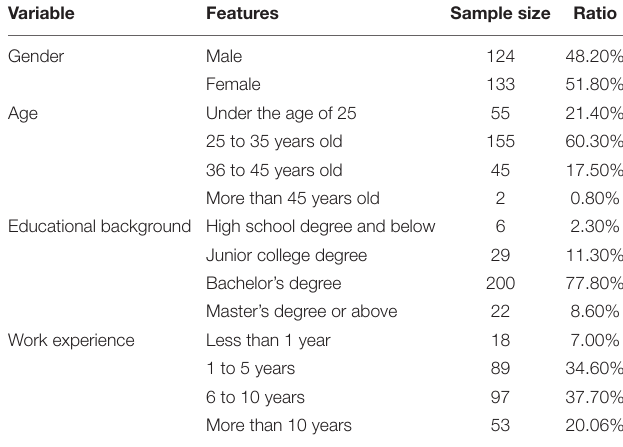
TABLE 1 | Sample structure ( n =